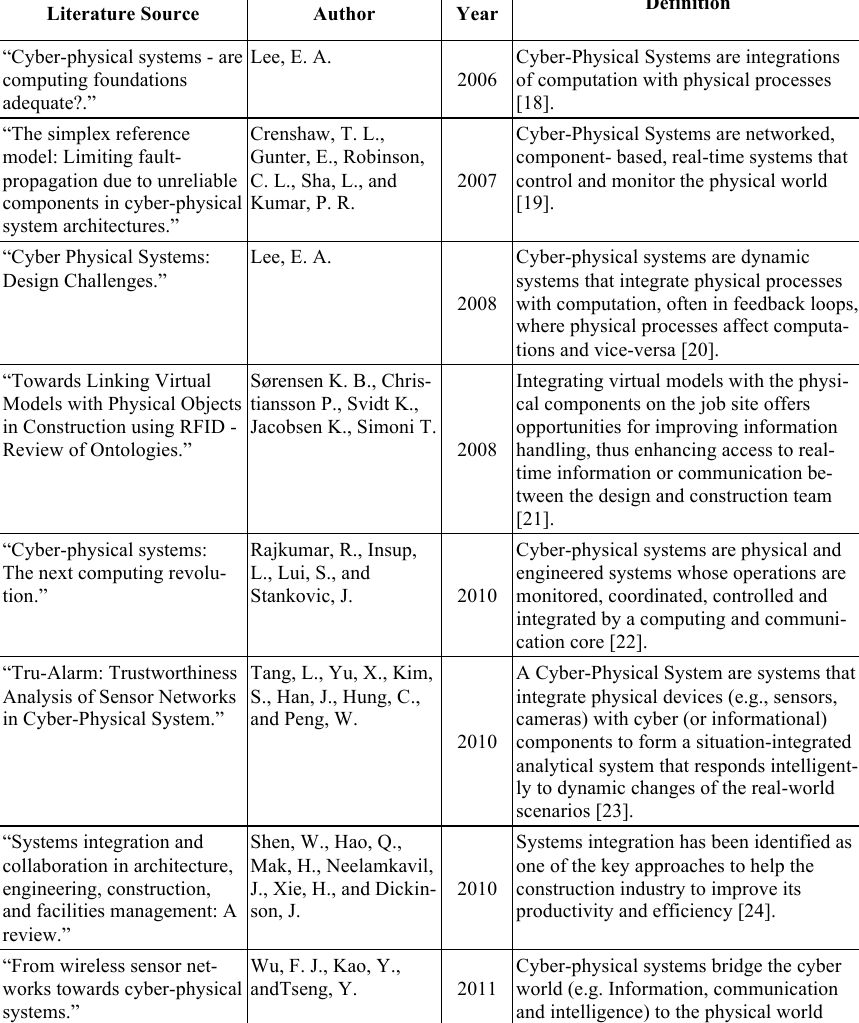
Table 1. Definitions of The Term Cyber-physical